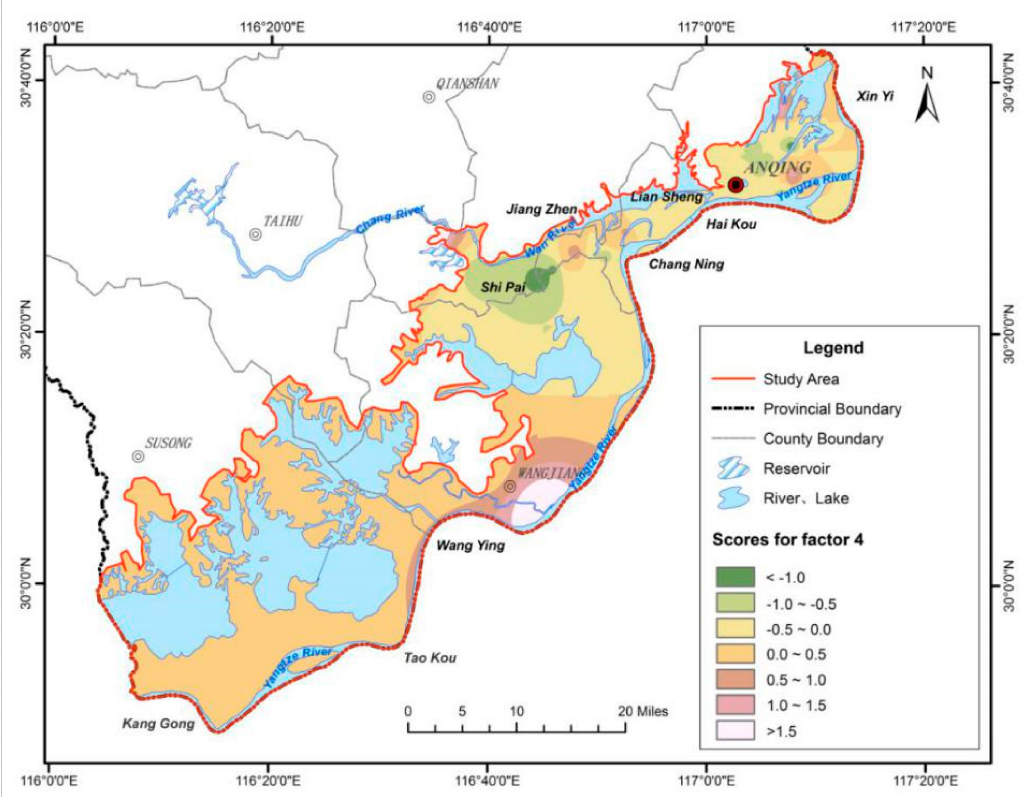
Figure 13. Distribution of scores of factor 4 for confined